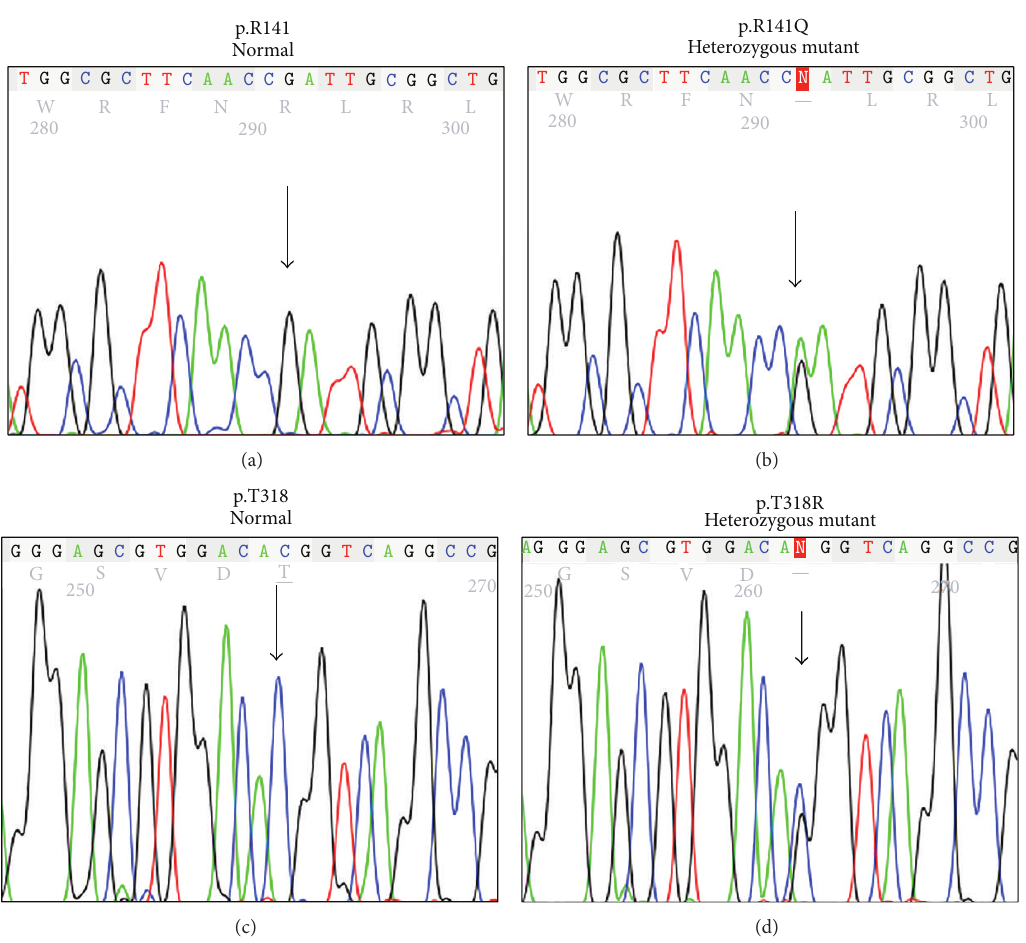
Figure 2: Sequencing electropherograms showing CYP11B1 mutations in Patient 3. Wild-type CYP11B1 DNA sequences encoding p.R141 (a) and p.T318 (c) from a normal individual are shown as reference. Patient 3 is compound heterozygous for a novel exon 3 p.R141Q mutation on one allele (b) and an exon 5 p.T318R mutation on the other allele (d) of the CYP11B1 gene.